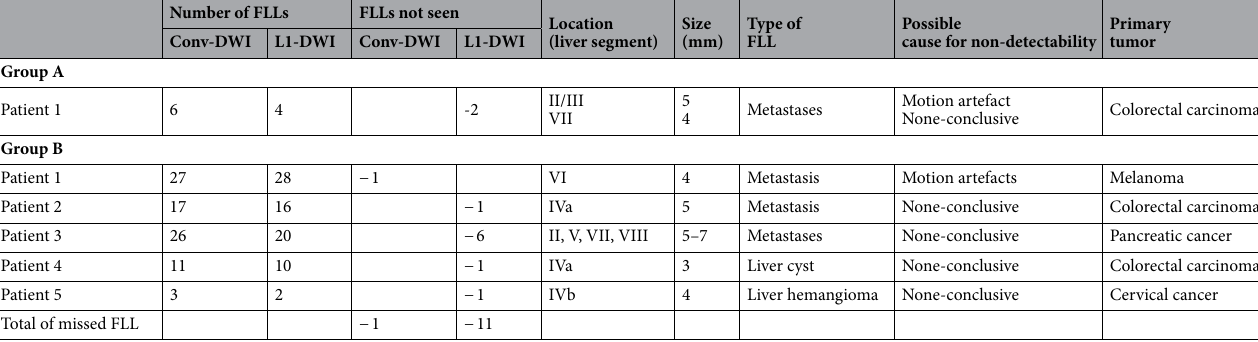
Table 4. Patients with FLLs not detected on conv-DWI or L1-DWI. FLL Focal liver lesion, conv-DWI Single-shot EPI-based DWI with parallel imaging reconstruction, L1-DWI Single-shot EPI-based DWI with L1-regularized iterative